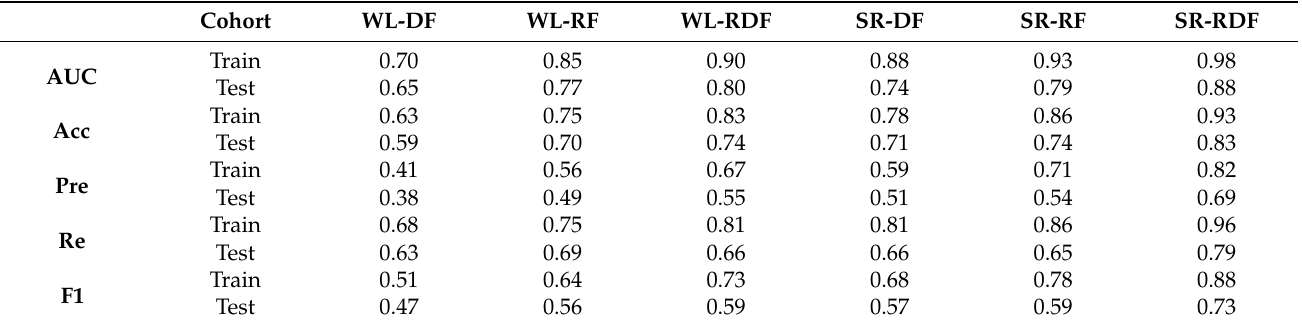
Table 2. The average evaluation results of the models using features of WL-DF, WL-RF, WL-RDF, SR-DF, SR-RF, and